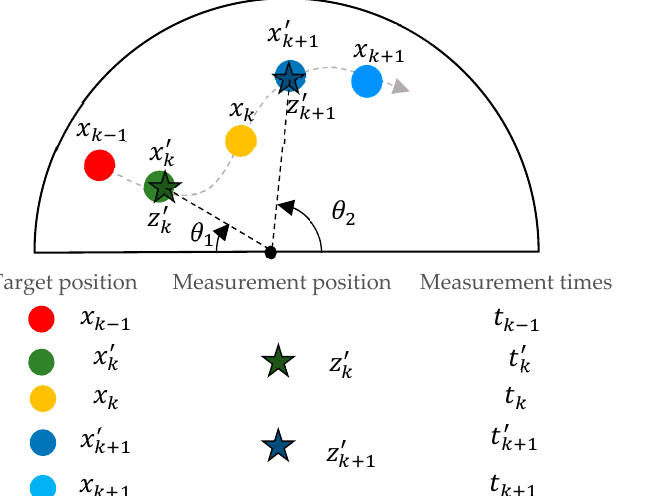
Figure 2. Diagram of the relationship between the actual position and the measured position of the target during radar two-dimensional scanning.